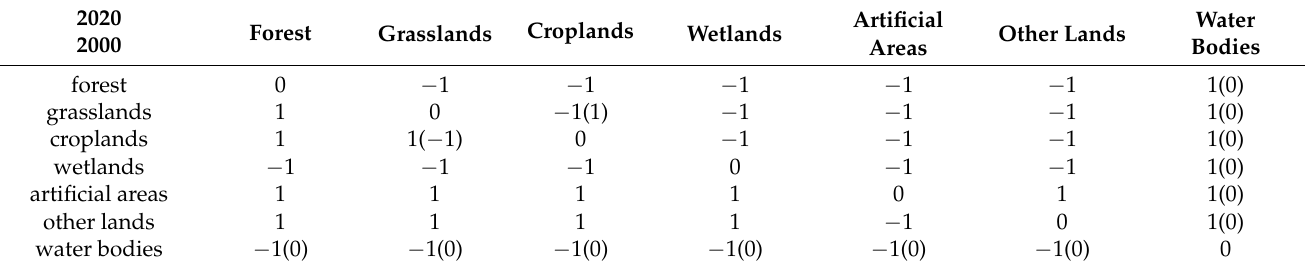
Table 3. Comparison of modified and UNCCD LUCC evaluation